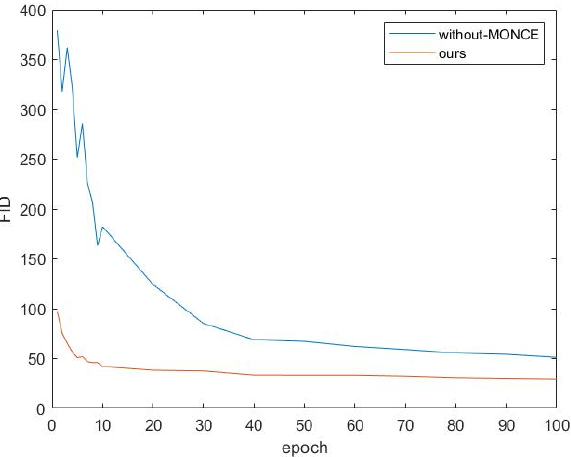
Figure 13. Variation of FID with the number of training epochs.